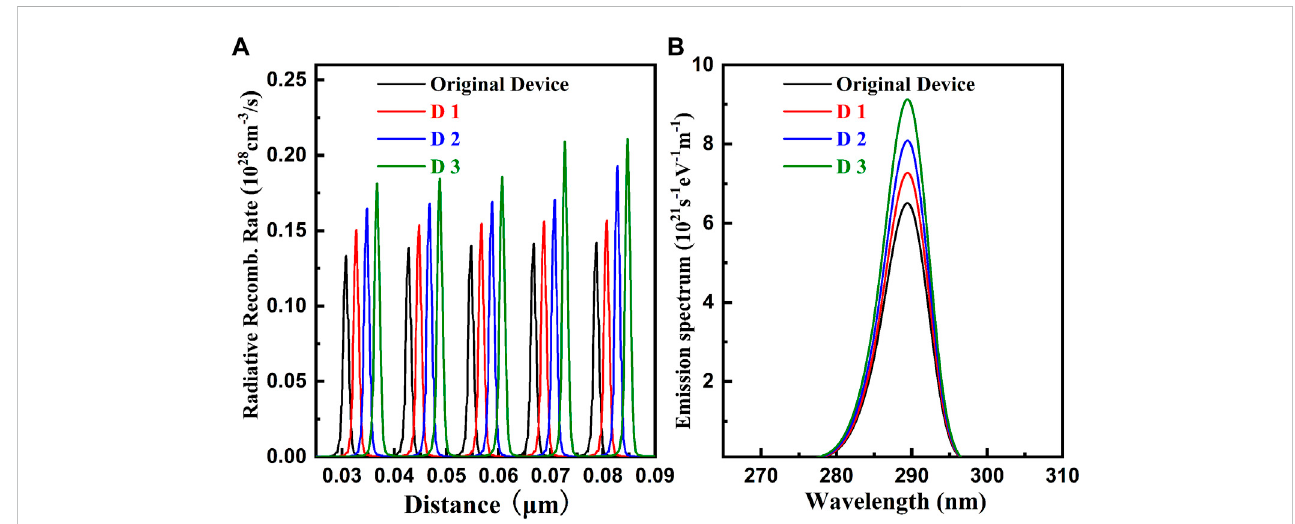
FIGURE 5 (Color online) (A) Radiative Recombination Rate and (B) Emission spectrum of four devices at 200